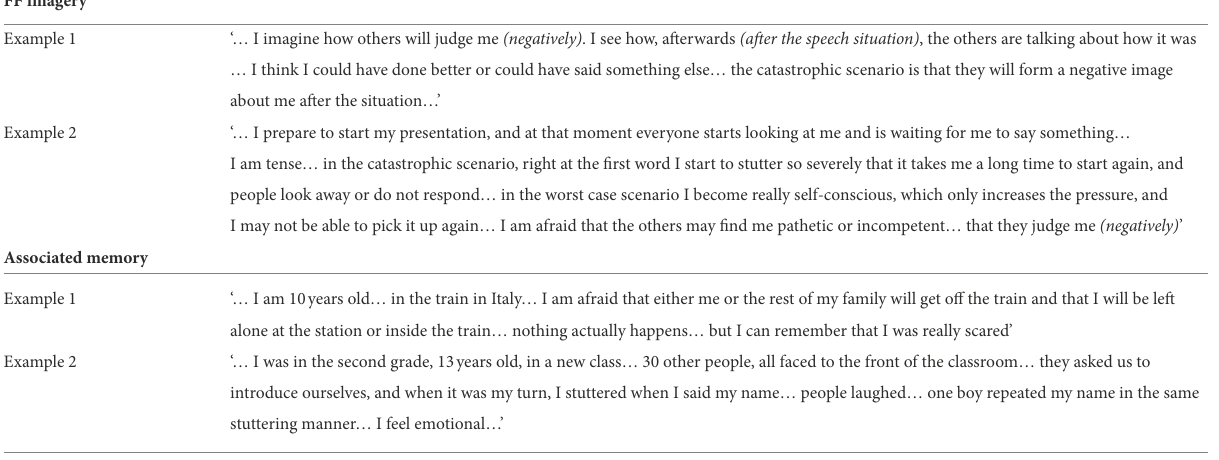
TABLE 2 Examples of reported flashforward imagery and associated memories.